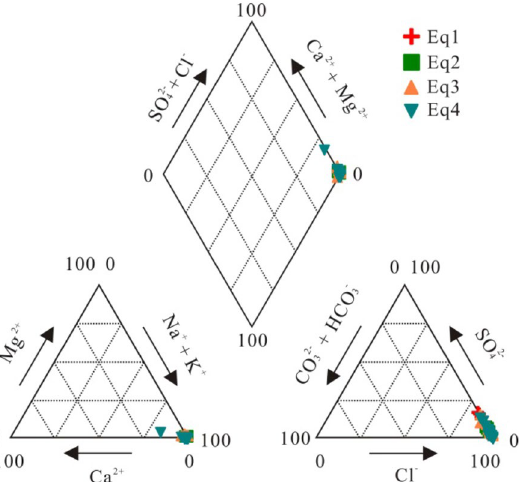
Figure 2. Piper diagram for oilfield brines in the Qianjiang Depression. The ratios plotted in the diagram are normality